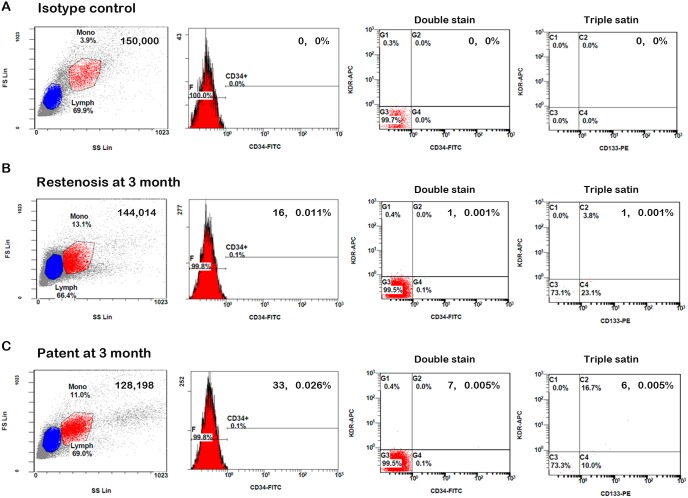
Representative flow cytometry analysis.Panels show mononuclear cells (MNCs) that were gated by forward/sideward scatter (FSC/SSC) in isotype controls (A), patients with restenosis (B), and patients without (C) restenosis at 3 months. The numbers of circulating endogenous progenitor cells (EPCs) were defined as CD34+, CD34+KDR+, and CD34+KDR+CD133+, respectively.